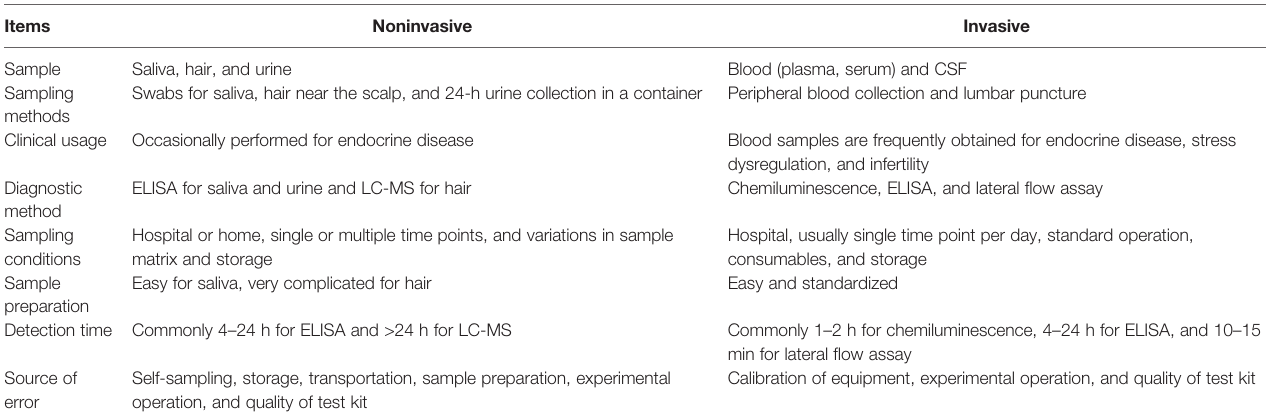
TABLE 2 | Comparison of the invasive and non-invasive methods for detecting